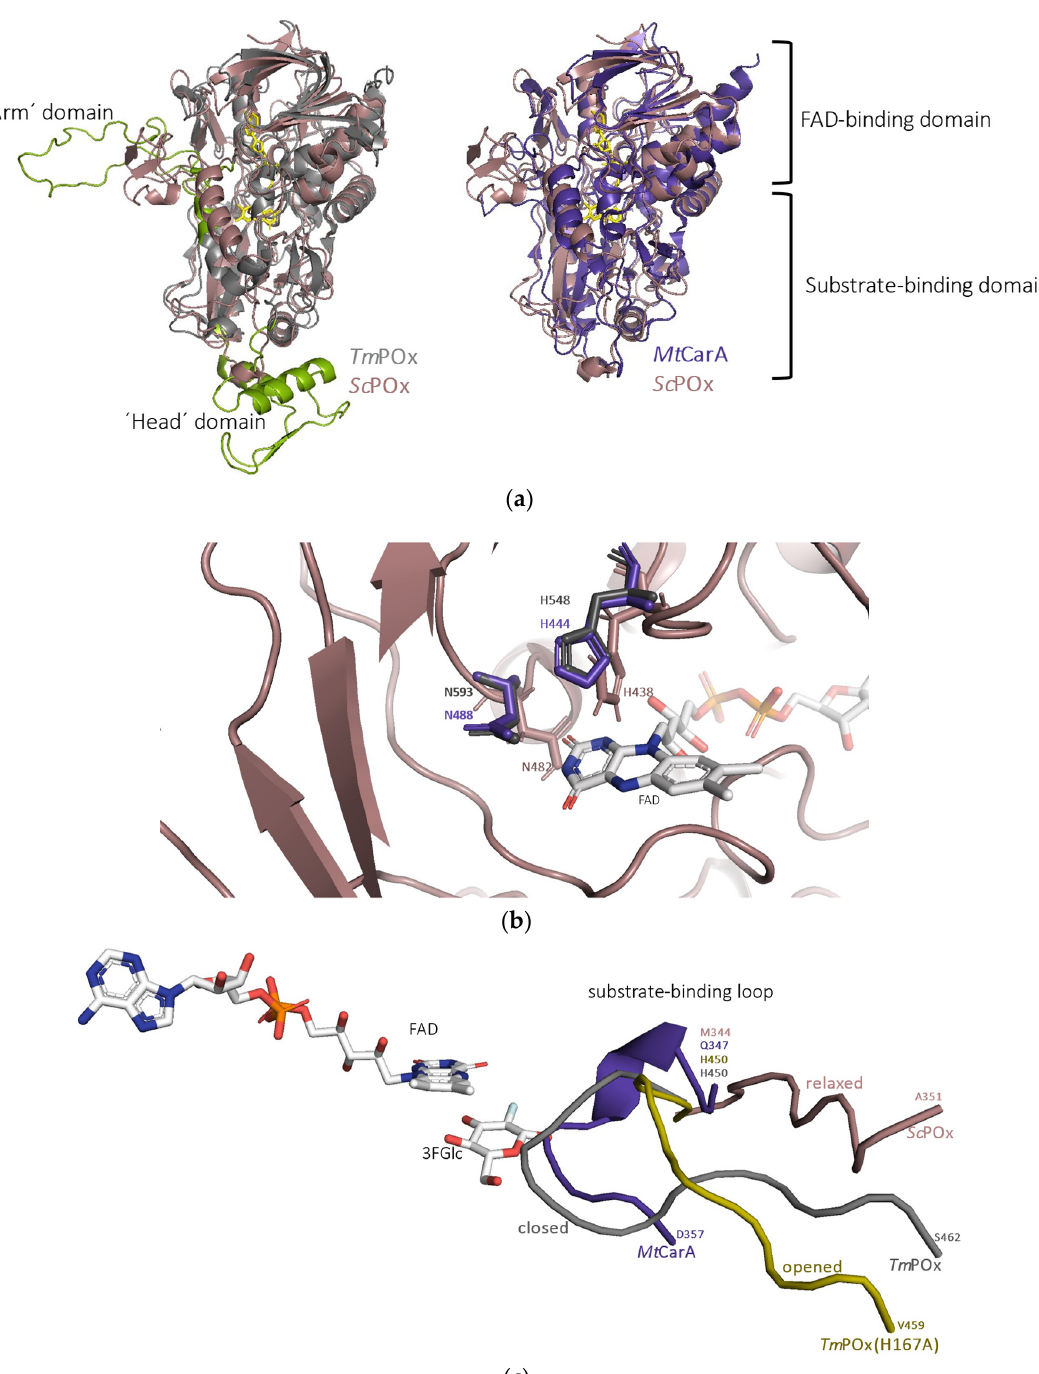
Figure 5. Structural model of pyranose oxidase from Streptomyces canus ( Sc POx). ( a ) Superimposi- tion of pyranose oxidase from Trametes multicolor ( Tm POx) (grey, only one monomer shown) and Mt CarA from Microbacterium trichothecenolyticum (purple) with Sc POx (pink) in cartoon mode. The FAD molecule from the crystal structure of Tm POx or Mt CarA is depicted in yellow. Important oligomerization parts of the Tm POx structure are coloured green (“arm” residues 105–158 and “head” residues 368–430); ( b ) Comparison of the spatial positions of the catalytic His-Asp dyad of Sc POx (pink) with those of Tm POx (grey) as well as Mt CarA (purple). The FAD moiety is shown in light grey; ( c ) Comparison of different substrate-binding loop conformations of Sc POx (pink), Mt CarA (purple), Tm POx (grey) and Tm POx variant H167A (yellow). FAD and the 3-fluoroglucose molecule (from structure 2IGO) are shown in light grey.